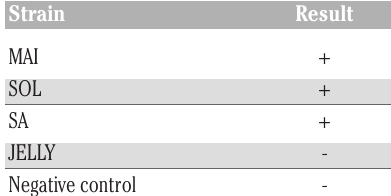
Table 1. Results of pathogenicity test.